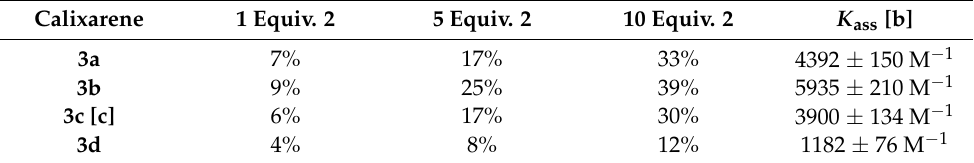
Figure 3. Absorbance–emission spectra of compounds 3a – d . Table 1. Emission intensity dependence on the concentration of 2 [a]. % Decrease in Emission With these fluorescent calixarenes in hand, we moved to explore their complexation properties toward 2 . As expected, addition of 2 to a 10 µM solution of a calixarene in 1,2-dichloroethane (DCE) resulted in the fluorescence decrease (Figure 4). Titration of the solutions of 3 with 1–10 equiv. of 2 allowed measurements of binding constants (Table 1), which were in the same range reported for calix[4]arene receptors from the UV meas- urements in chloroform at similar concentrations [10]. The overall numbers (~4000–6000 M − 1 ) are higher than K ass obtained by the 1 H NMR technique ( K ass = 162 ± 13 M − 1 for 3c ) at